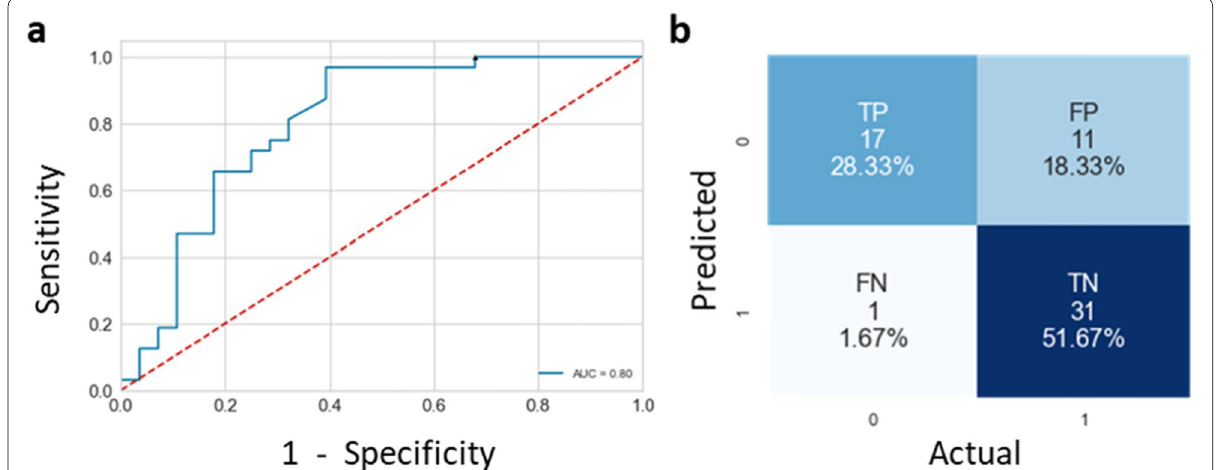
Fig. 1 Receiver operating characteristics curve ( a ) and confusion matrix ( b ) from gradient boosting models on batch corrected validation